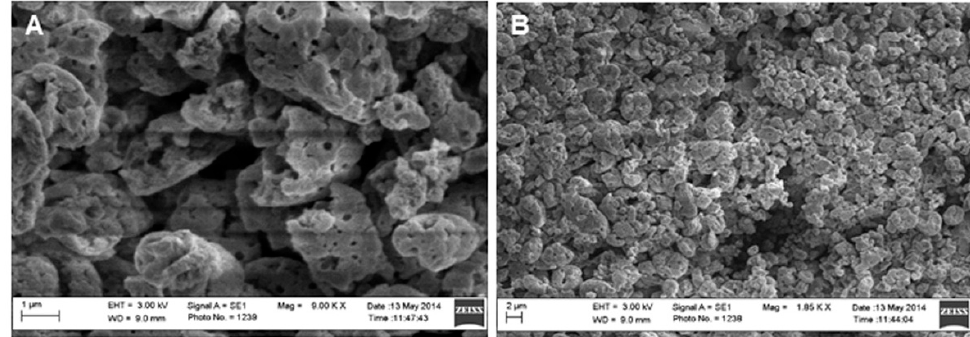
Figure 3. Scanning electron microscopy images of cationic CHL NPs/NCMPs: ( A ) 1 µm scale and ( B ) 2 µm scale.